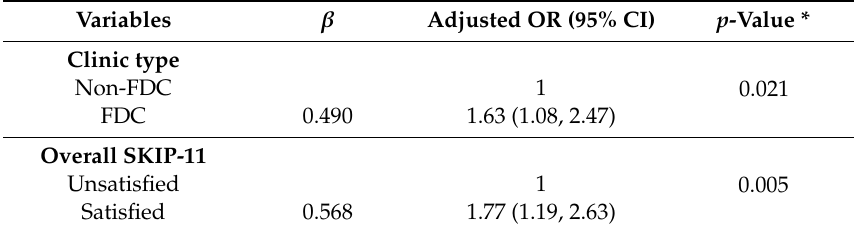
Table 5. Association between FDC-implemented clinic and doctor-patient interaction satisfaction towards glycaemic control by multiple logistic regression ( n =